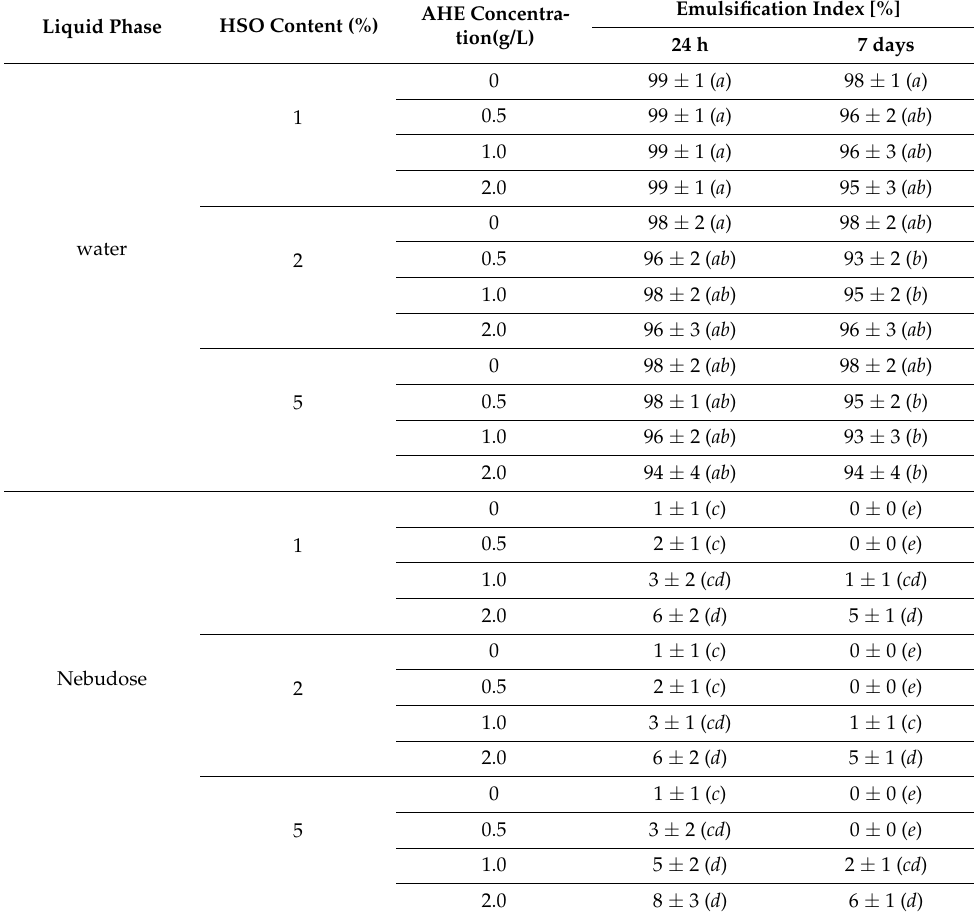
Table 2. The emulsification index of the tested samples after 24 h and 7 days.